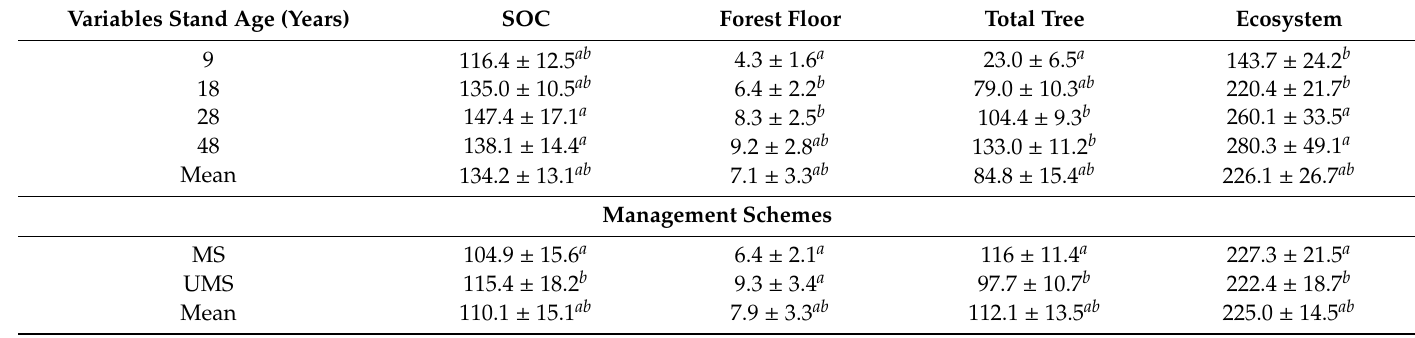
Table 3. Ecosystem carbon storage (Mg ha − 1 ) in the four stand age groups and two management treatments of P. massoniana plantations. Di ff erent lower-case letters within columns indicate the significance level among di ff erent